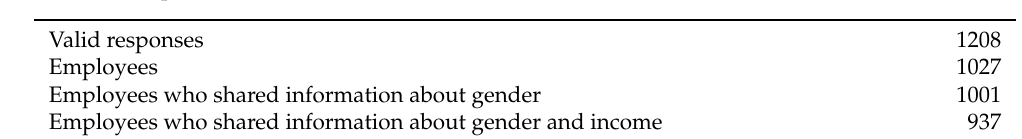
Table 1. Sample information.